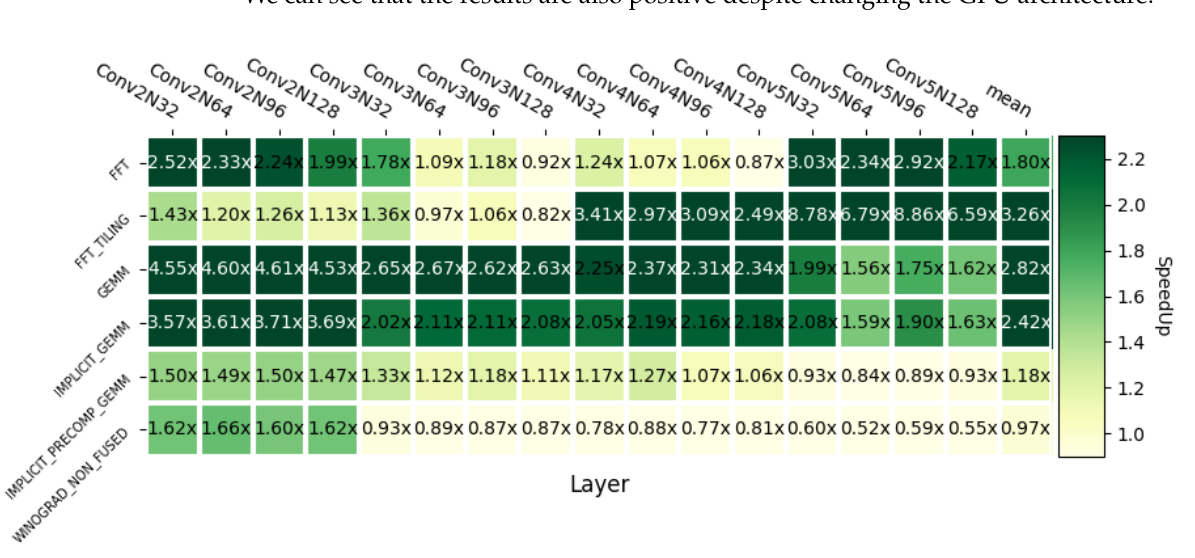
Figure 19. Heatmap with respect to other cuDNN convolution algorithms on Ampere RTX